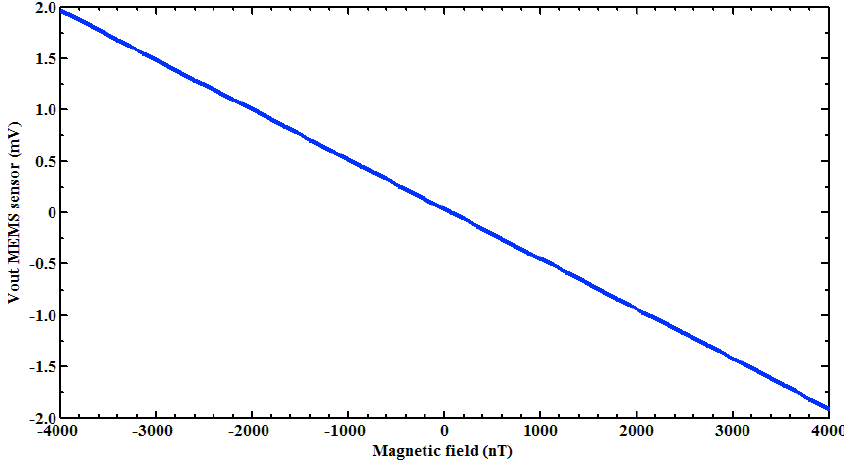
Figure 7. Filtered PCB output voltage (amplified 1,000 times) of the MEMS sensor as a function of the magnetic field density.